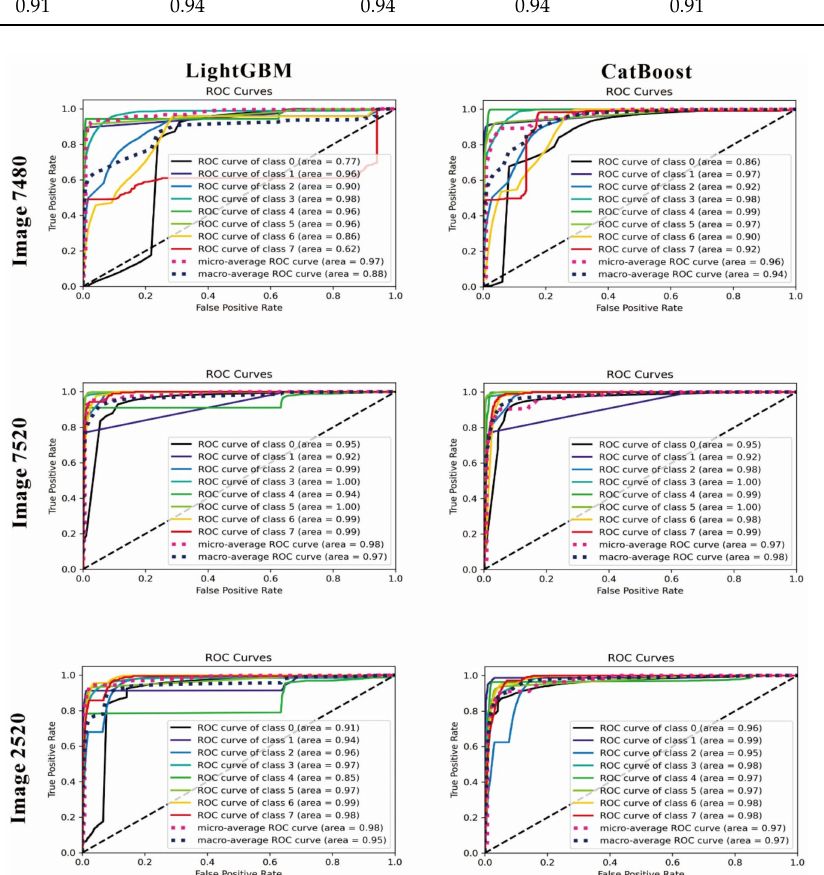
Figure 7. Multi-class ROC-AUC curves of GBDT classifiers in case